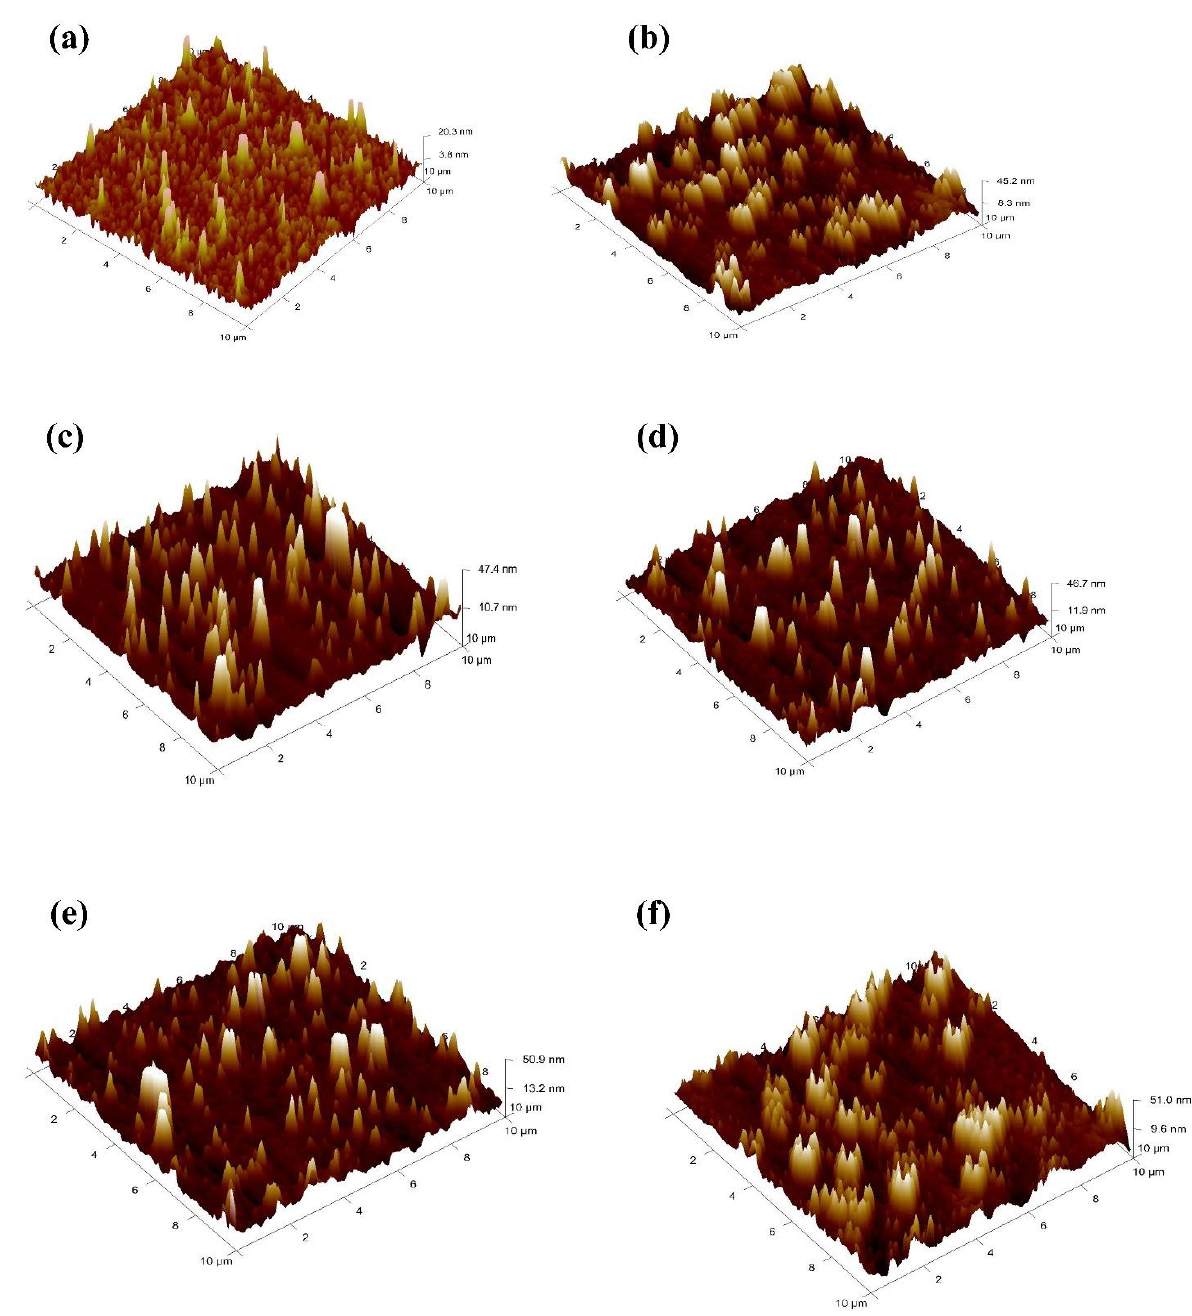
Figure 4. The AFM topographical images of the buffer layer ( a ) PEDOT:PSS only (without NPs, S1), ( b ) Au@Ag-8% (S2), ( c ) Au@Ag-10% (S3), ( d ) Au@Ag-12% (S4), ( e ) Au@Ag-14% (S5), ( f ) Au@Ag-16%